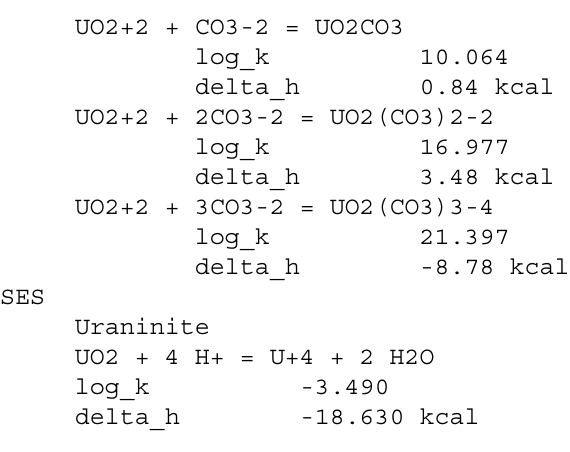
Table 11. Output for example